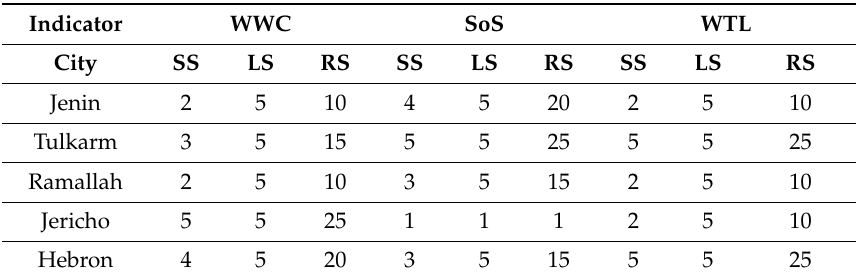
Table 11. Risk score (RS) for the wastewater coverage (WWC), water treatment level (WTL) and the state of sewage system (SoS).